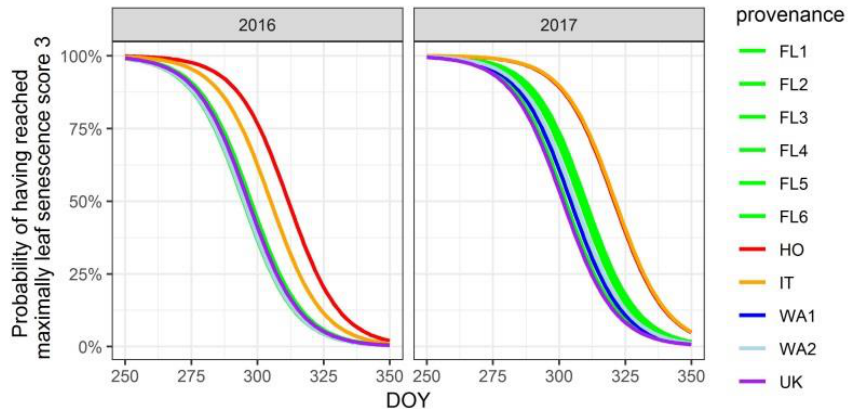
Figure 4. Modeled timing of leaf senescence for the different provenances in 2016 and 2017. Modeled probability of having reached a maximal leaf senescence score of three.